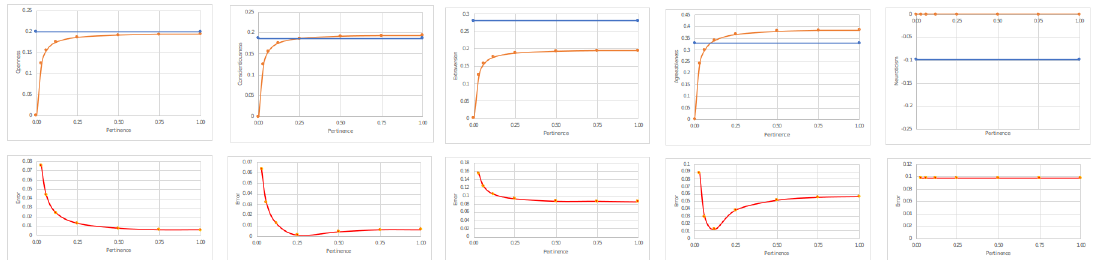
Figure 13. Error graphics from Happy For input emotion—OCEANS’s factors.